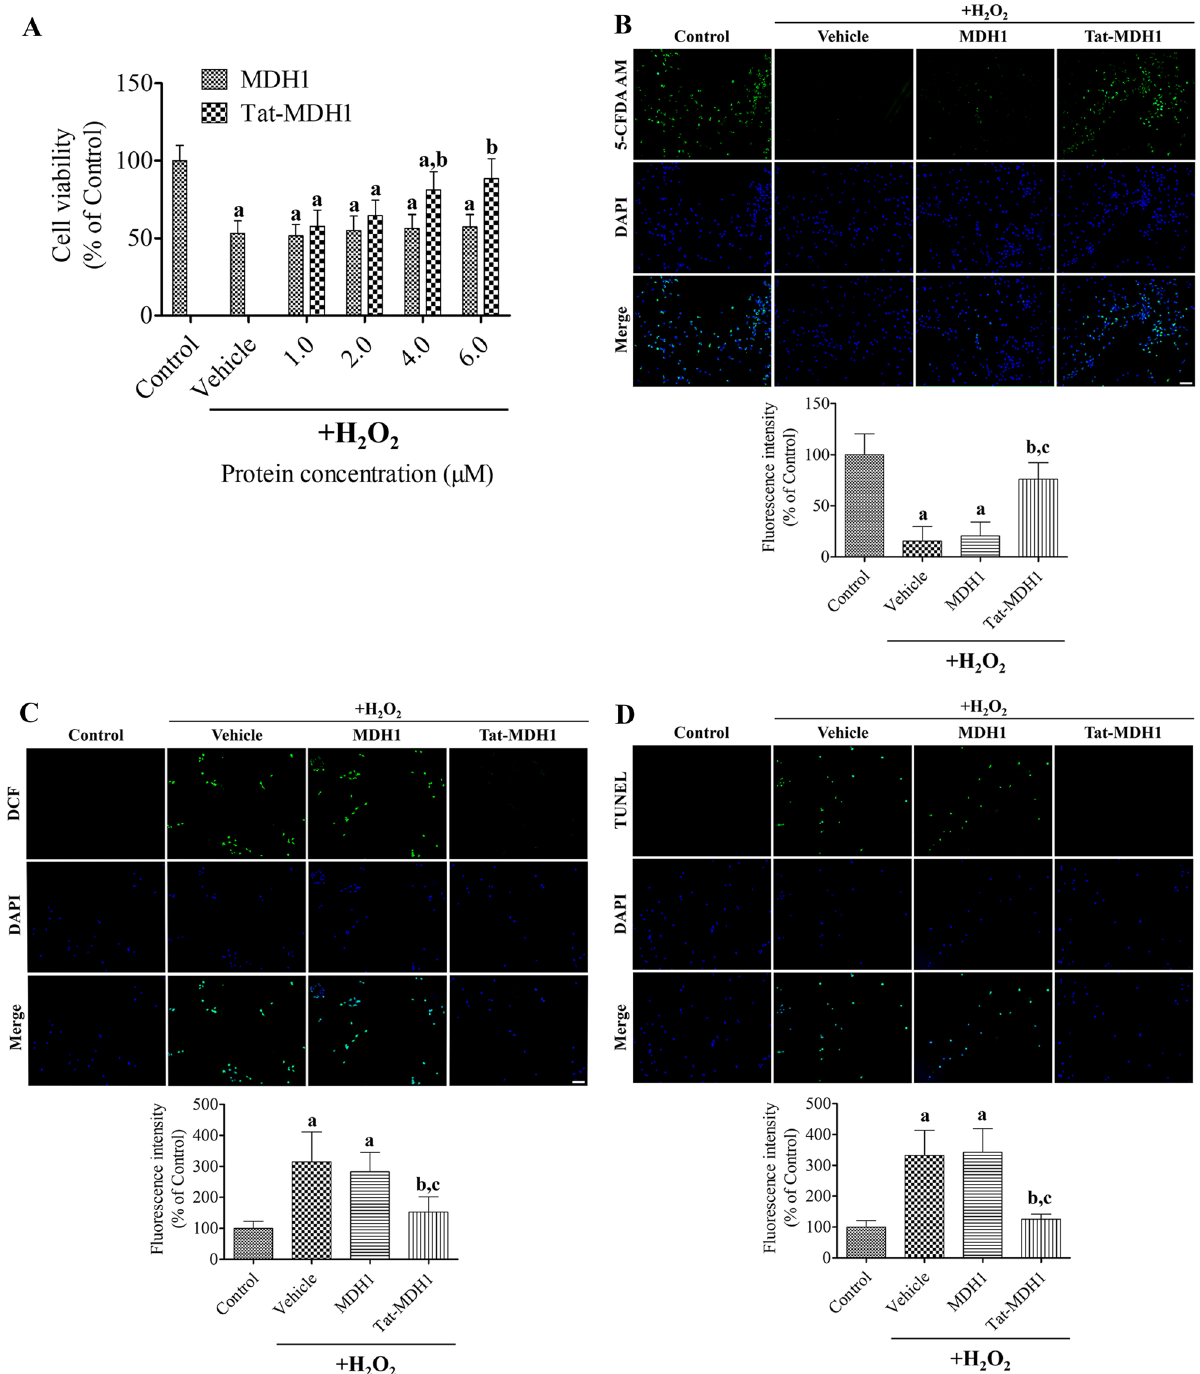
Figure 2. In vitro neuroprotective effects of Tat-MDH1 against 200 μM H 2 O 2 -induced oxidative stress in HT22 cells. ( A ) Concentration-dependent effects of Tat-MDH1 were observed using a water-soluble tetrazolium salt (WST-1) assay 1 h after incubation of protein and hydrogen peroxide (H 2 O 2 ). ( B – D ) Survived cells, ROS formation, and DNA fragmentation were visualized by 5-carboxyfluorescein diacetate acetoxymethyl ester (5-CFDA AM), 2,7-dichlorofluorescein diacetate (DCF-DA), and deoxynucleotidyl transferase-mediated deoxyuridine triphosphate-biotin nick end labeling (TUNEL) staining respectively, in HT22 cells 1 h after 4 μM Tat-MDH1 and 200 μM H 2 O 2 . Scale bar = 50 μm. All assays were performed in triplicate. Fluorescence intensities were quantified and data were analyzed using one-way analysis of variance followed by Tukey’s multiple comparison post hoc test ( a p < 0.05, significantly different from the control group; b p < 0.05, significantly different from the vehicle group; c p < 0.05, significantly different from the MDH1 group). Data are shown as mean + standard